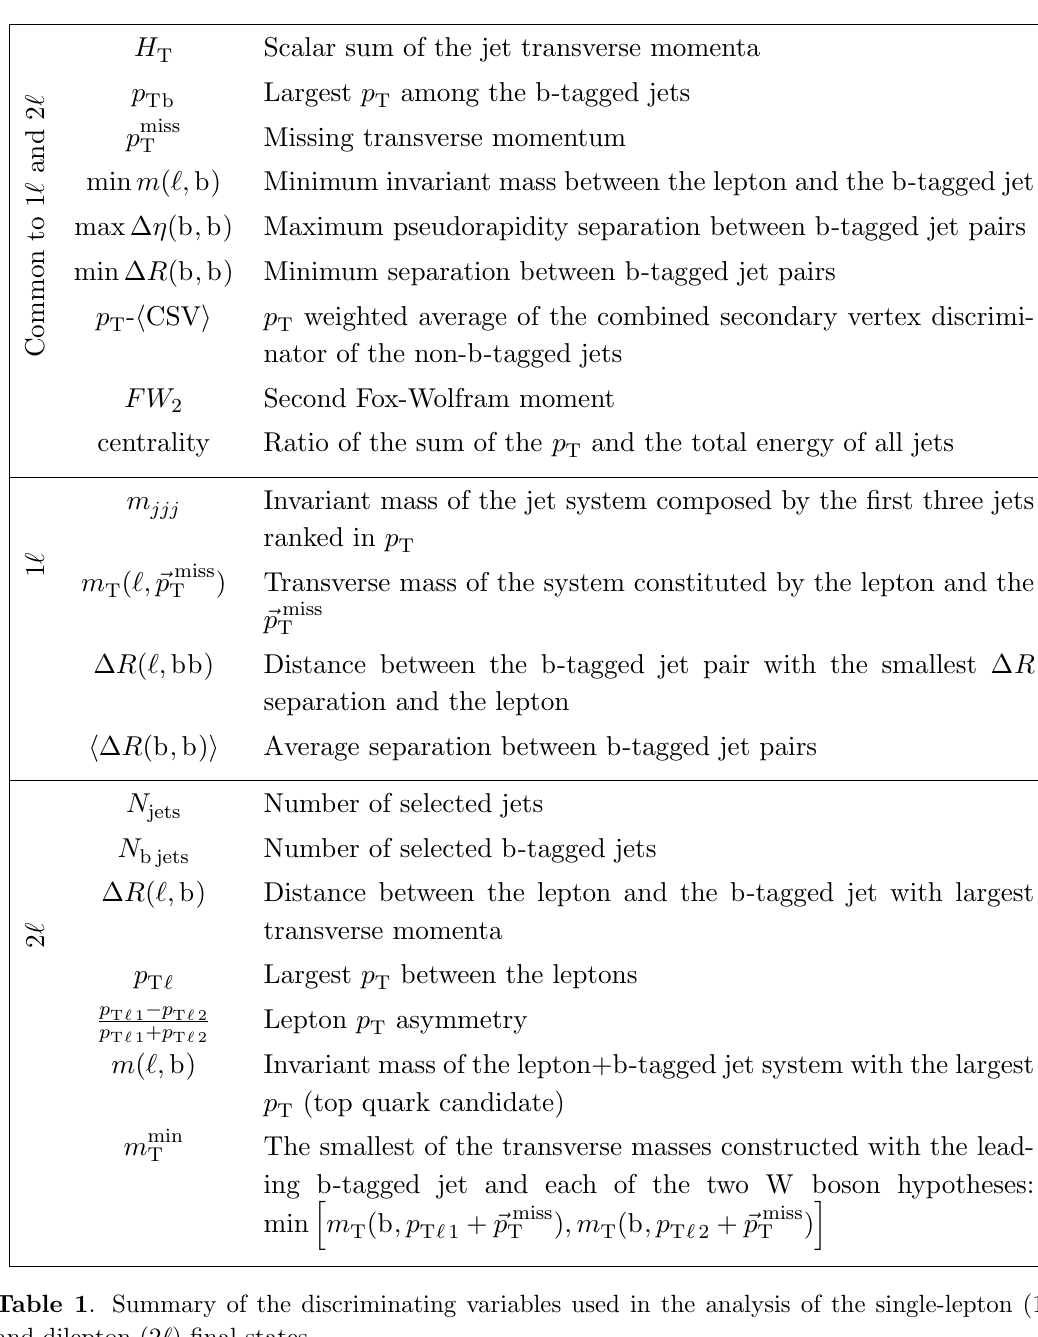
, and T and the T